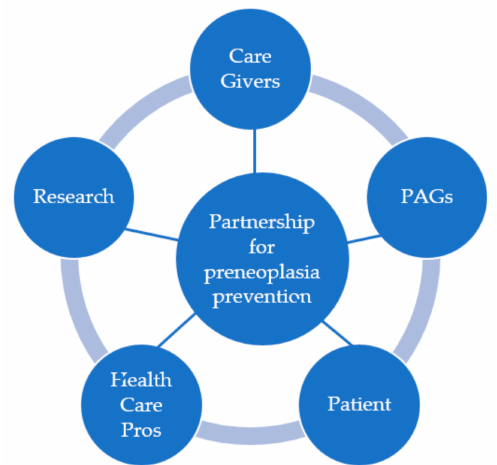
Figure 2. Scheme showing PAGs involvement. PAGs are today involved with awareness campaigns, lobbying, and education of both health care systems as well as the survivor and the newly diagnosed. The PAGs are a link between the clinician and the patient, making sure that the medical terminology used is explained in layman language and that psychological support is available during and after treatment. Table 1. What PAGs are involved with currently, and what could be developed for other disease areas using similar